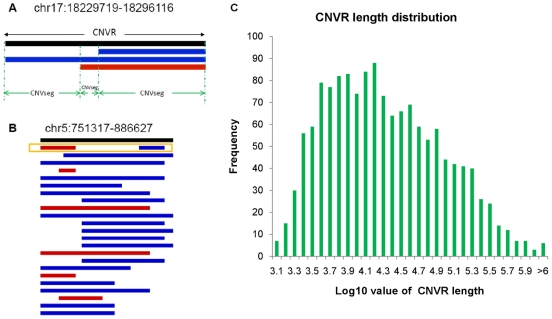
Copy Number Variable Region (CNVR) and Copy Number Variable Segment (CNVseg).Due to the inconsistent calling of CNV boundaries, CNVR refers to a union of overlapping CNVs while a CNVseg represents the minimal units of CNV. In the two panels, black bars denote CNVR, below which each bar denote a CNV call in one individual. Red and blue bars represent deletion and duplication, respectively. (A). An example of CNVR and CNVsegs on chromosome 17 starting from 18,229,719 to 18,296,116. Dashed lines (green) dissect CNVR into small contiguous CNVsegs. (B). An example of a complex CNV region. The rectangle (orange) points out that one individual has both deletion and duplication in the region, to which we refer as complex CNVR in this study. (C). CNVR length distribution. Length distribution of 1440 CNVRs constructed in this study ranges from 1.03 kb to 1.73 Mb.